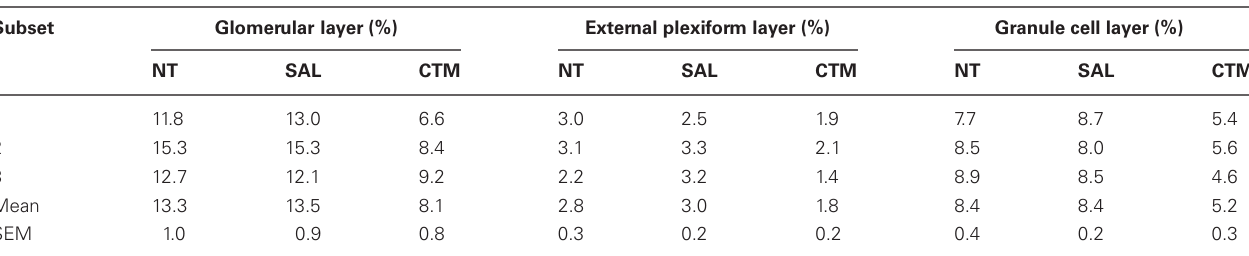
Table 1 | SERT-ir fiber density in the olfactory bulb of male rats. Subset Glomerular layer (%) External plexiform layer